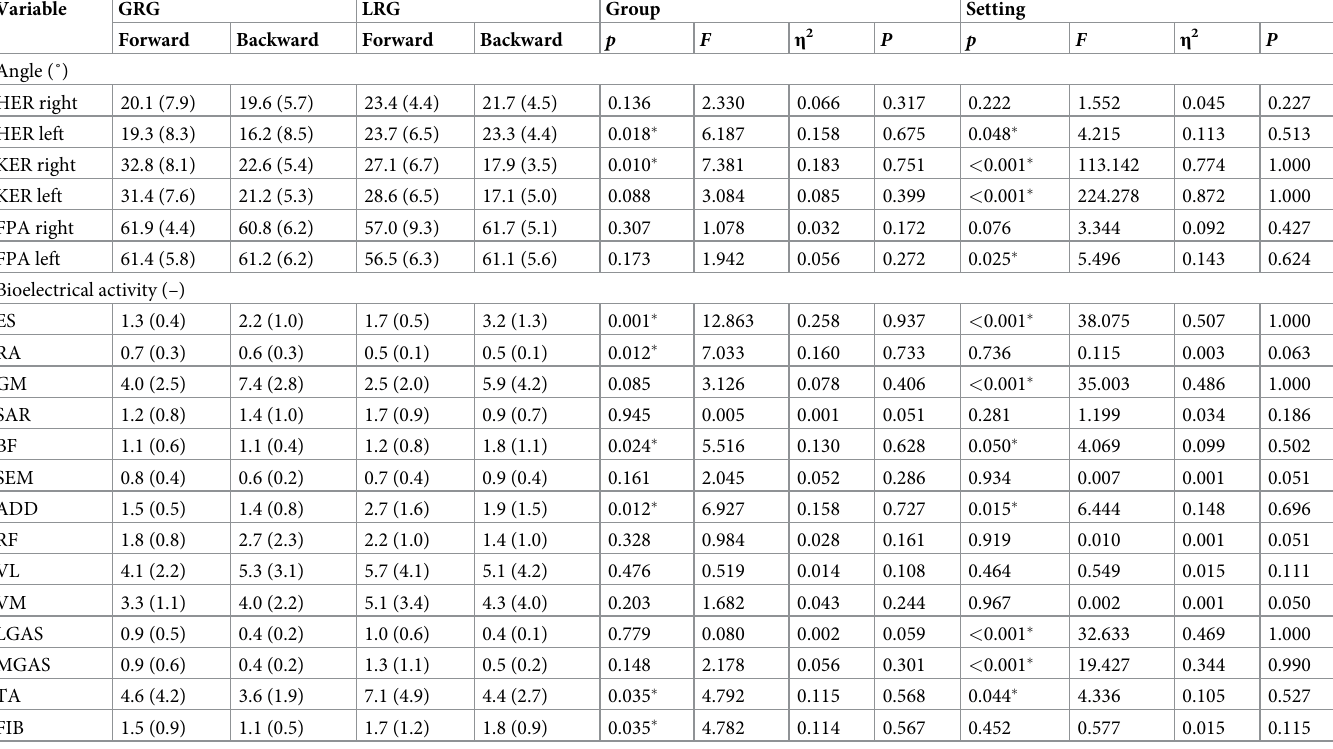
Table 4. Mean (SD) of the angles and bioelectrical activity in the fourth classical position (CP4), and p value, F statistic, effect size estimates and observed power of the repeated-measures ANOVA for group and setting factors. Variable GRG LRG Group Setting